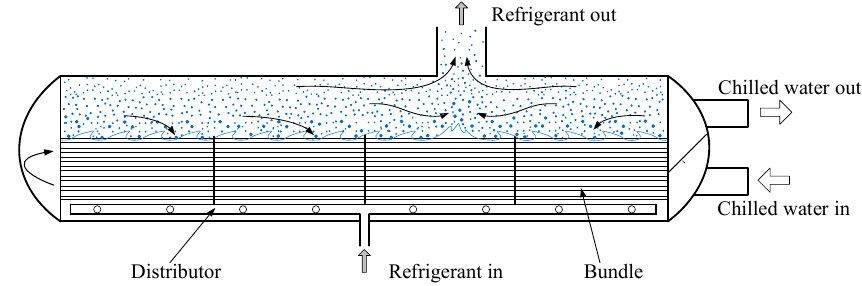
Figure 1. Schematic diagram of liquid entrainment in a flooded evaporator.